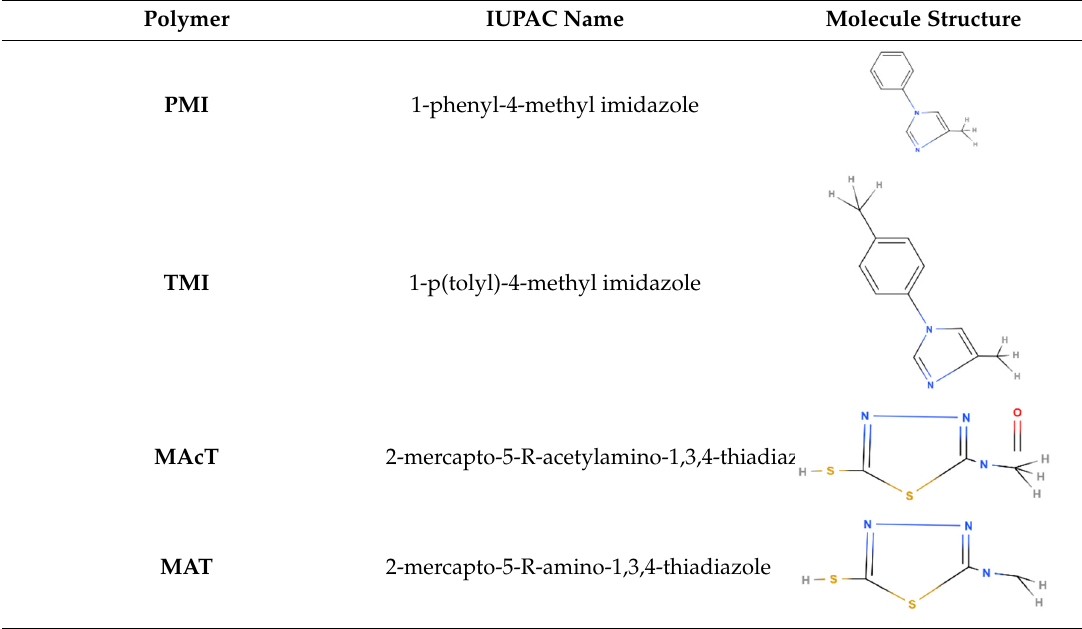
Table 4. Polymers used by Muresan et al. for protecting bronzes.